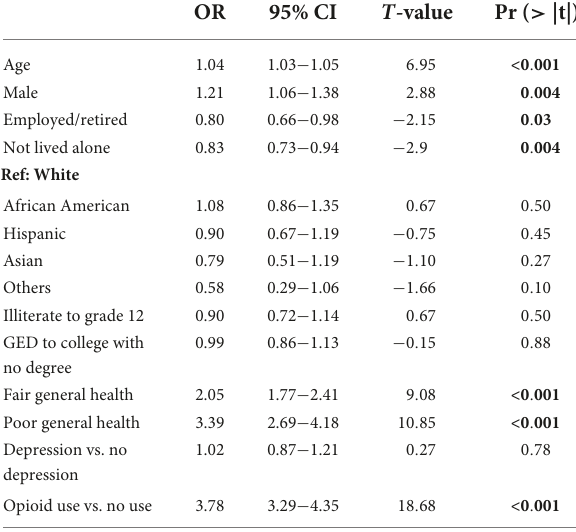
TABLE 3 Logistic regression on the relationship between prescribed opioid use and